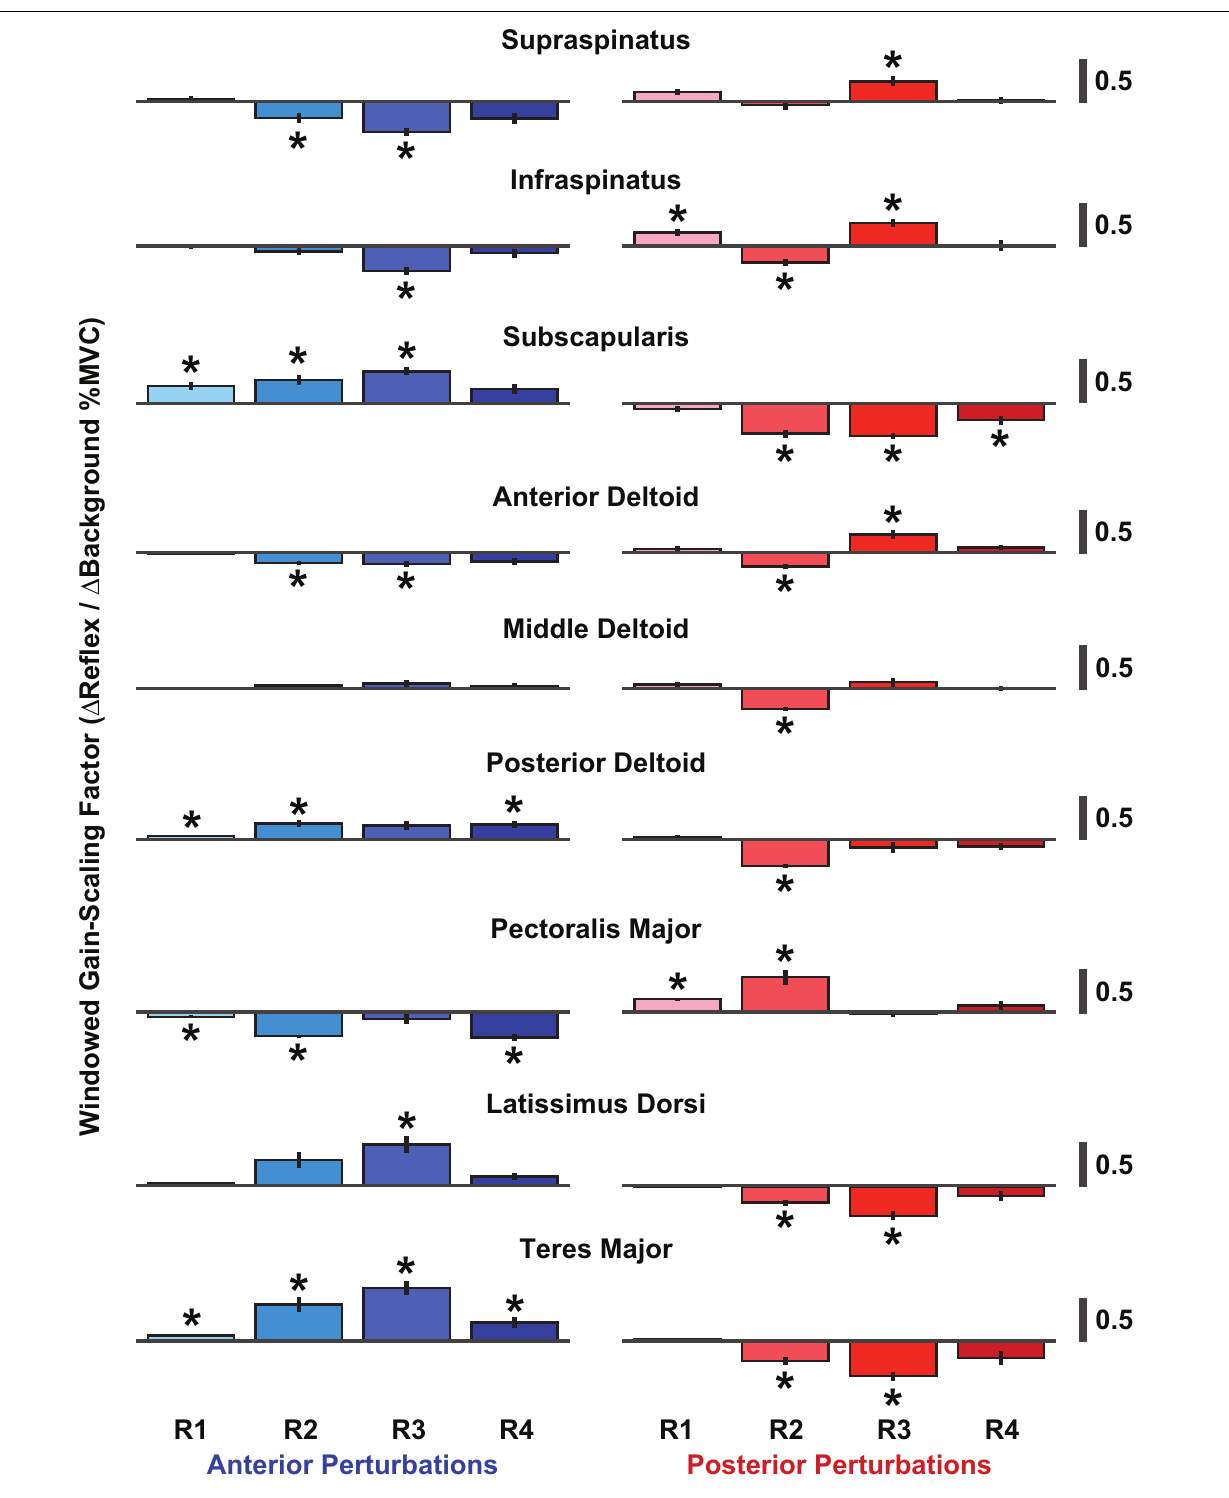
FIGURE 7 | Windowed gain-scaling factors for stretch-evoked reflexes in shoulder muscles responding to translations of the glenohumeral joint. The gain-scaling factor was computed from the relationship between a muscle’s background activity and its reflex response in a given reflex window. Gain-scaling factors marked with an asterisk were significantly different from zero ( α = 0.05/72). Vertical black lines represent the standard errors of the gain-scaling factors. Reflex windows: R1 (20–40 ms), R2 (40–60 ms), R3 (60–80 ms), R4 (80–100 ms).